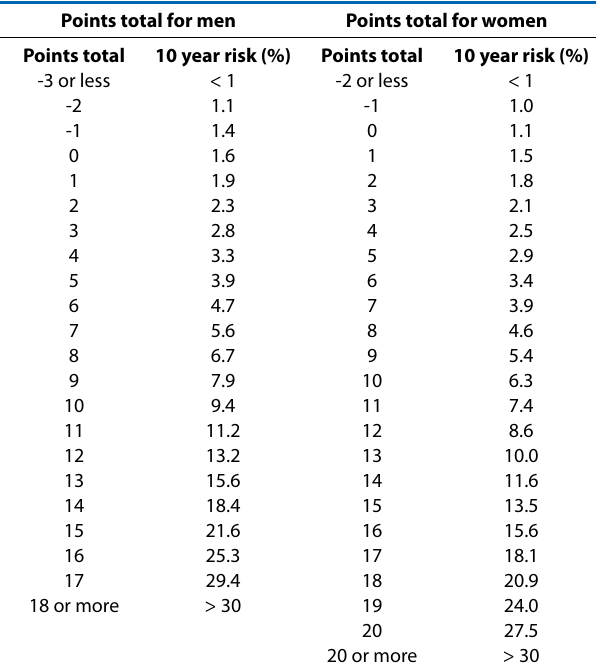
Table 8: Conversion of the points to 10-year risk percentage of cardiovascular risk Points total for men Points total for women Points total -3 or less